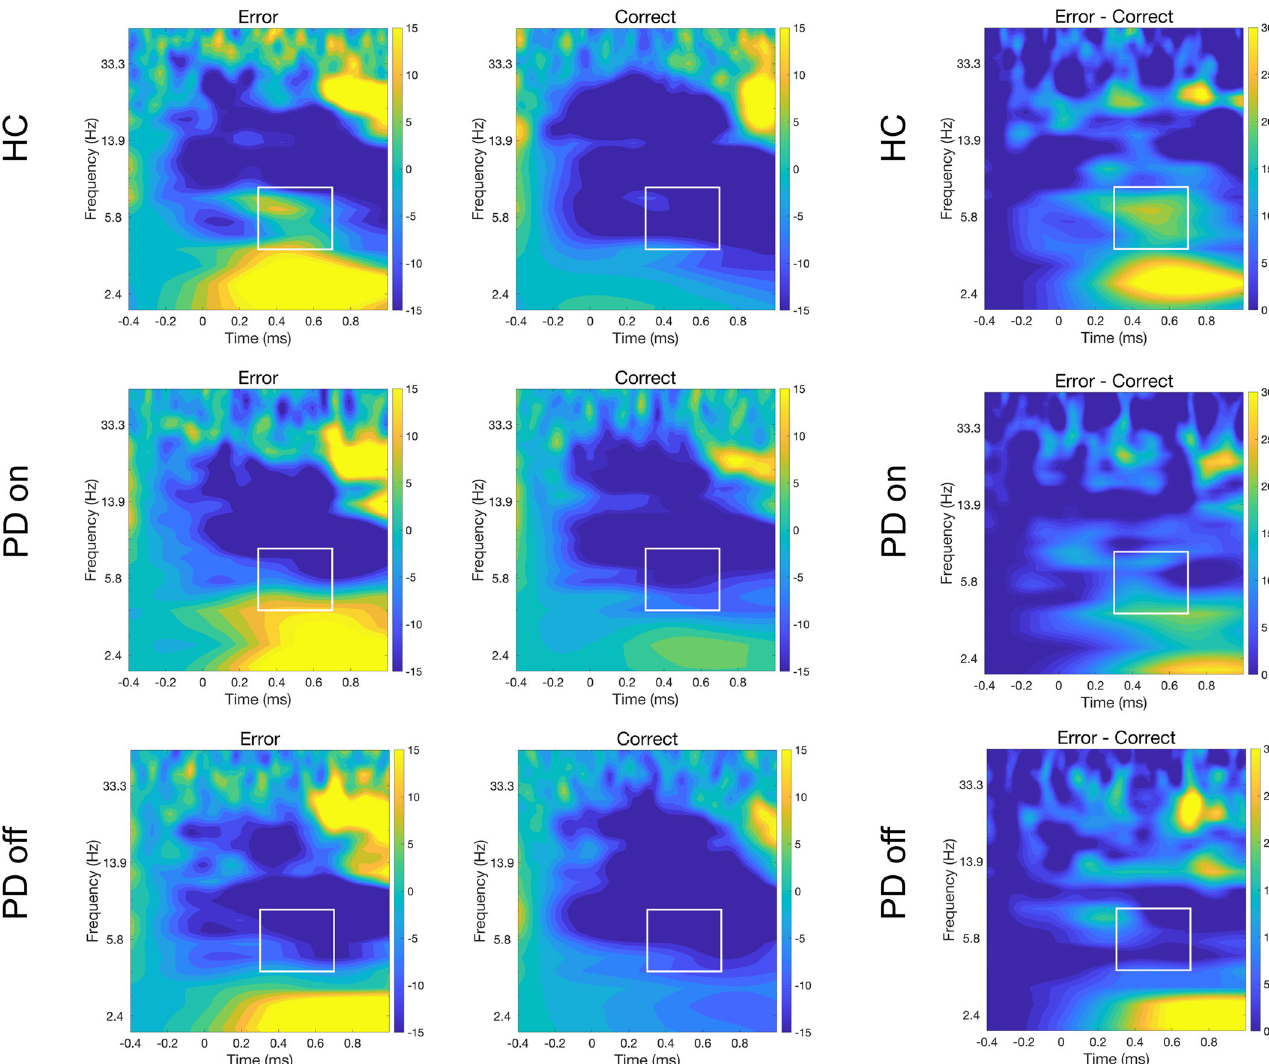
Fig. 3 TF representation of relative power change (in %) with respect to baseline for incorrect and correct actions. The end of the avatar ’ s arm-path deviation is at 0 ms. Incorrect and correct plots for electrode FCz between 1 and 50 Hz are shown for each group. Differential plots (erroneous − correct actions) are provided in the third column. The white rectangles demark the a priori chosen window of interest between 300 – 700 ms and 4 – 8.1 Hz, which were the values used for statistical